Question: In a single sentence, describe what this figure presents.
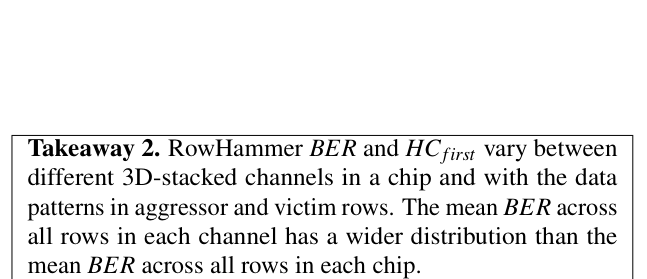
Answer: shows the BER over each DRAM row in a bank when we use the worst-case data pattern (WCDP) to initialize the rows. Each color-coded BER curve represents the BER for rows in three different channels. The shaded regions indicate variable-sized subarray boundaries.4 For example, the green highlighted subarray (SA X) comprises 832, and the blue high- lighted subarray (SA Y) comprises 768 DRAM rows.